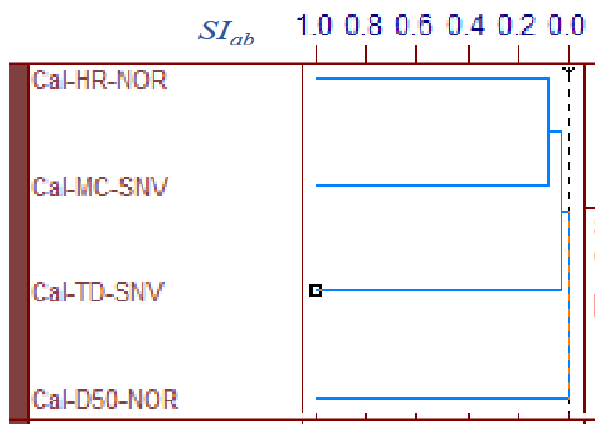
Figure 6. HCA dendrogram of the RVs of the best calibration models to predict the pharmaceutical properties of the HSWG granules. HCA: Hierarchical cluster analysis, SI ab : the standard scale of